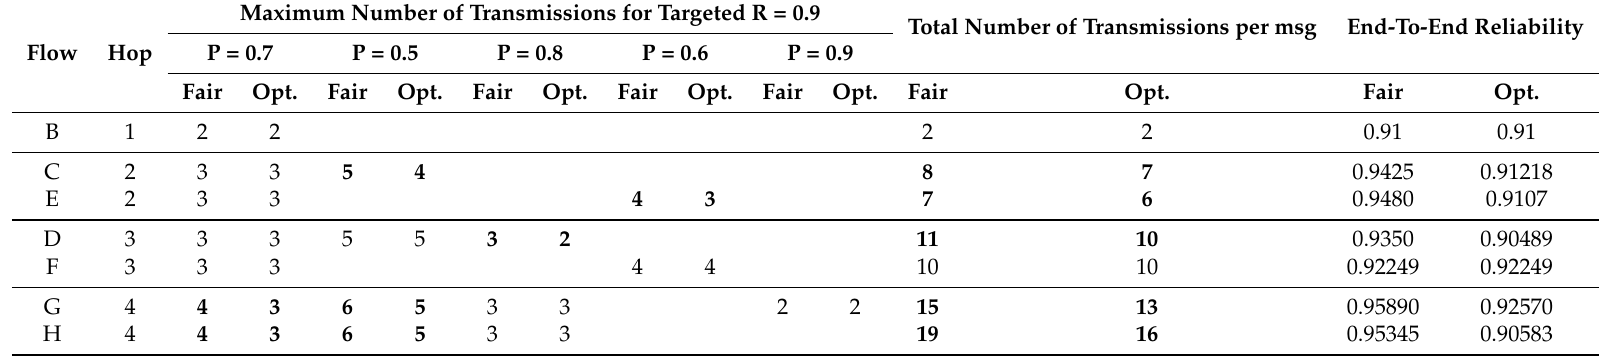
Table 3. Comparison of MFair and MOpt for a targeted end-to-end reliability R = 0.9 on seven flows. Maximum Number of Transmissions for Targeted R = 0.9